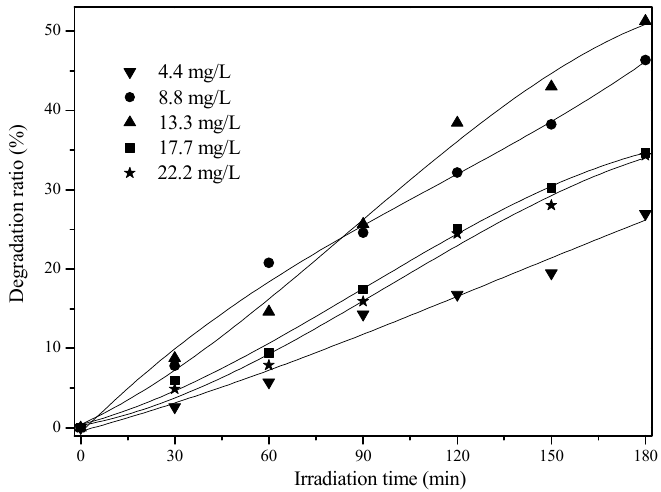
Figure 5. Effect of initial concentration on the degradation of chlorobenzene with Cu 2+ /K 2 La 2 Ti 3 O 10 .